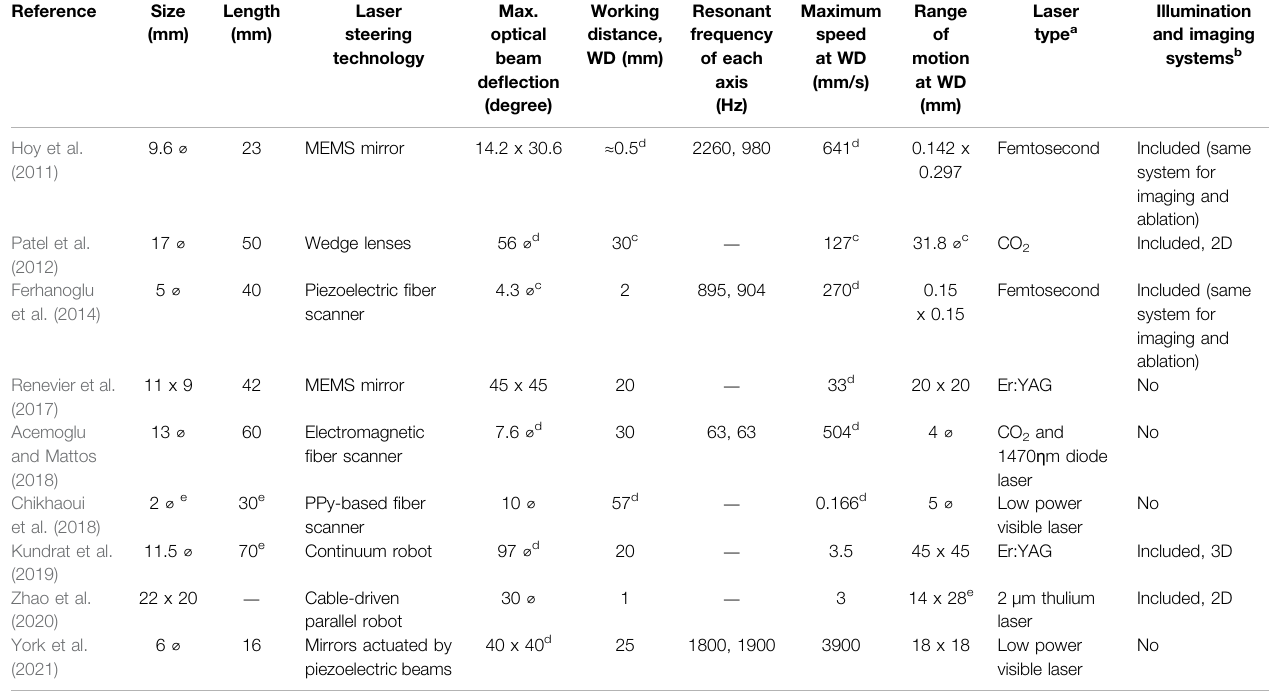
TABLE 1 | State of the art robotic laser manipulators for endoscopic laser microsurgery.